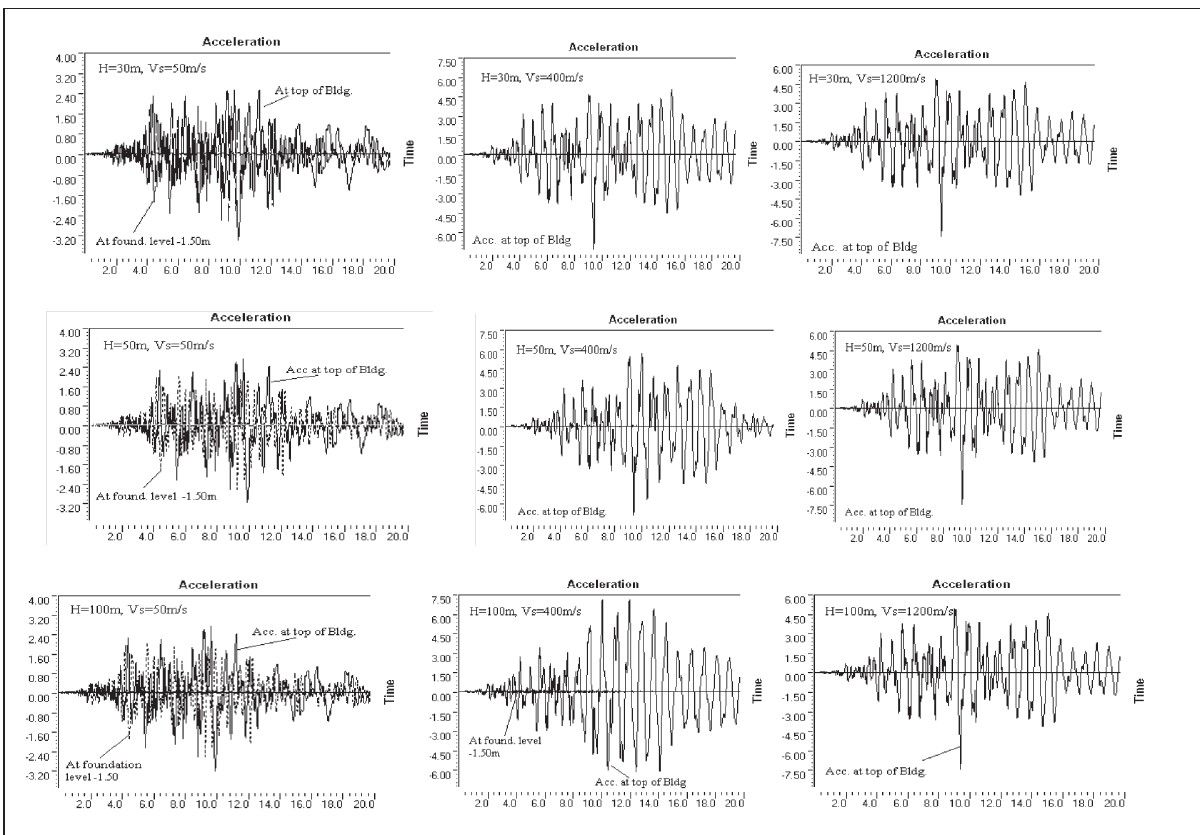
(cid:18)!.(cid:9)3) (cid:5)(cid:18)(cid:19)(cid:19)(cid:21)(cid:11)(cid:21)(cid:2)(cid:8)(cid:14)(cid:10)(cid:3)(cid:17)(cid:5)(cid:14)(cid:10)(cid:22)(cid:21)(cid:5)(cid:15)(cid:10)(cid:25)(cid:14)(cid:3)(cid:2)(cid:23)(cid:5);(cid:11)(cid:3)(cid:14)(cid:25)(cid:5)(cid:4)(cid:3)(cid:2)(cid:5) 1 (cid:5)T(cid:5)&$(cid:12)(cid:5)9$(cid:12)(cid:5)"$$(cid:5)(cid:22)P(cid:5) 8?